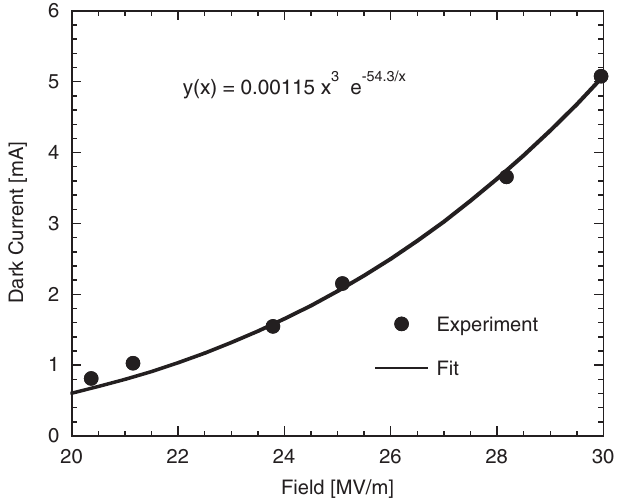
FIG. 5. Dark current in milliamps measured from the CsK photocathode surface in the Los Alamos high-brightness accel- erator FEL (HIBAF). The ‘‘fit’’ is based on the product of a Fowler-Nordheim current density vs field relation with a no- tional emission area vs field relation (see